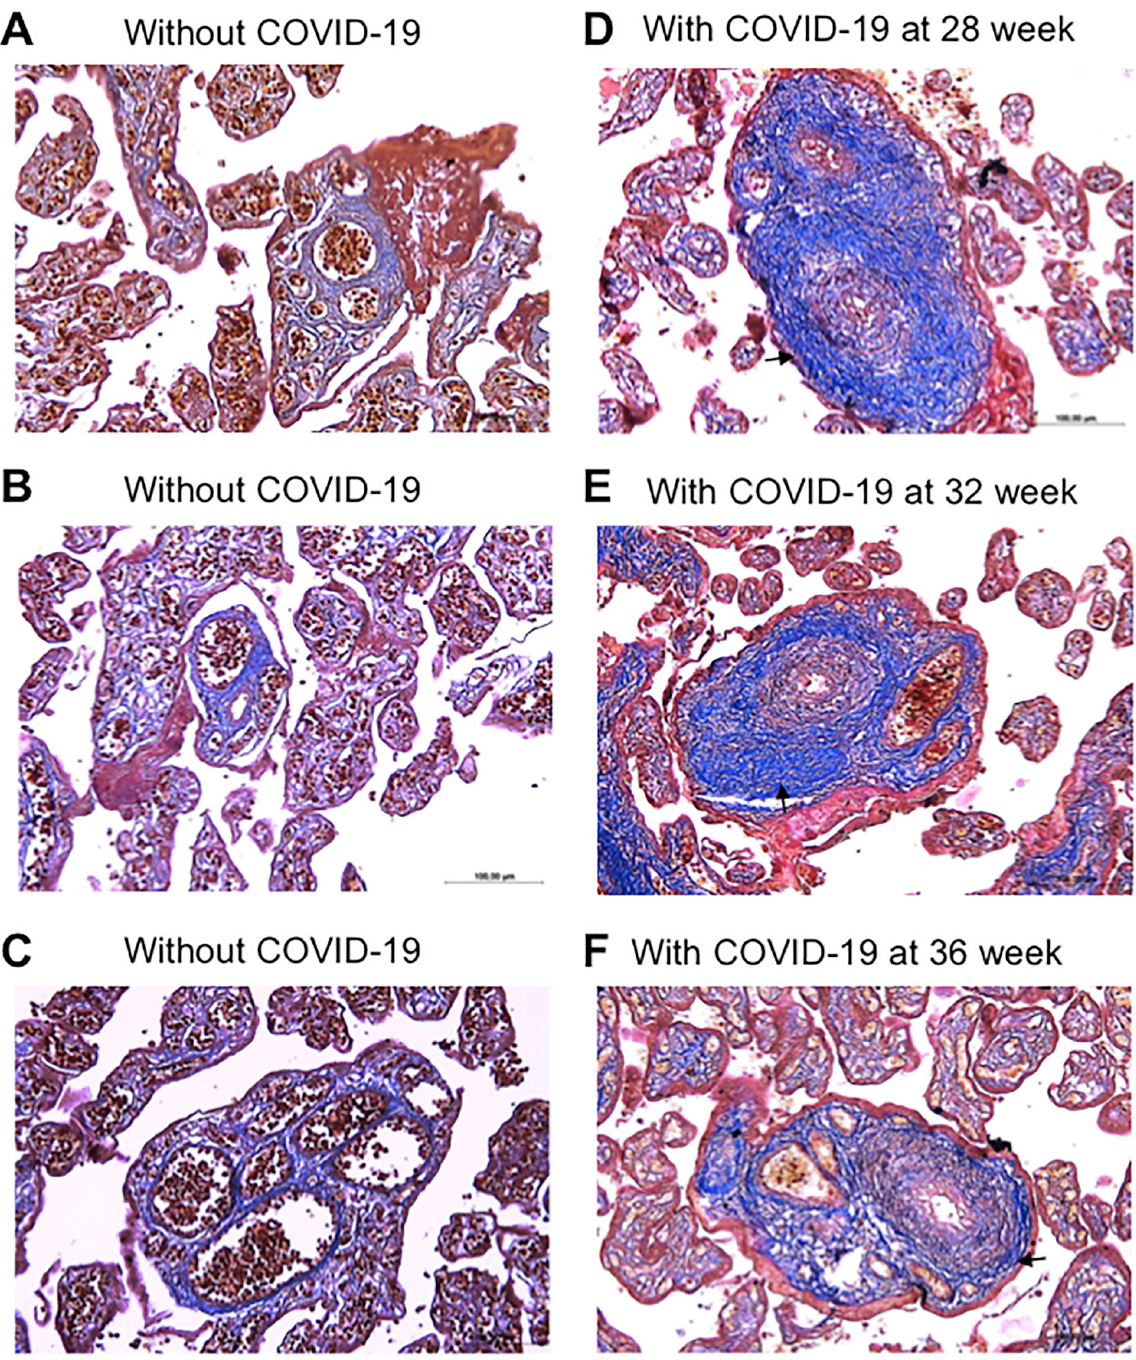
Fig 3. Masson’s trichrome staining. (A-C) Placentas of three representative women who gave birth without contracting COVID-19 (40 week of gestation). (D-E) Placentas of three representative women who gave birth (40 weeks of gestation) while contracting COVID-19 at 28, 32, or 36 weeks of gestation. Magnification x200. Arrows indicate remodeled